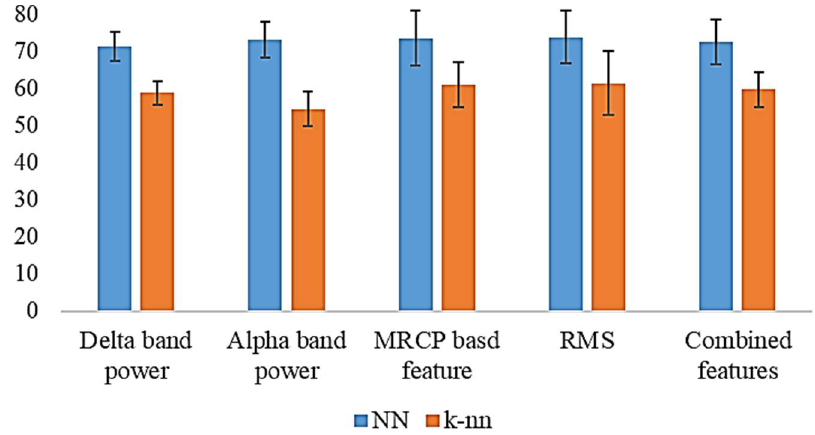
Figure 10. Summary of the results of the motion intention classifiers (error bars show the standard deviation).